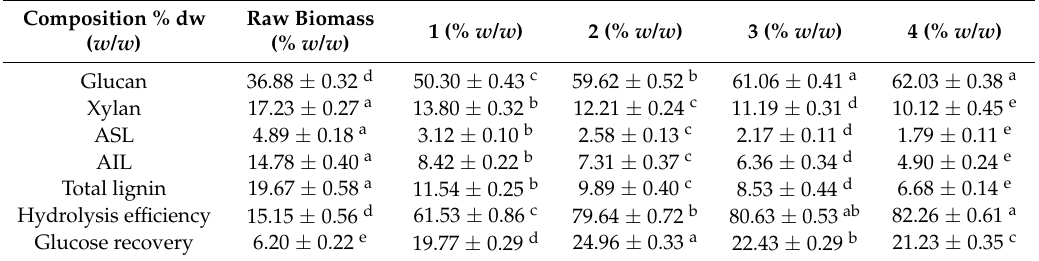
Table 2. Composition of C. barbata pretreated at 120 ◦ C using different concentrations of